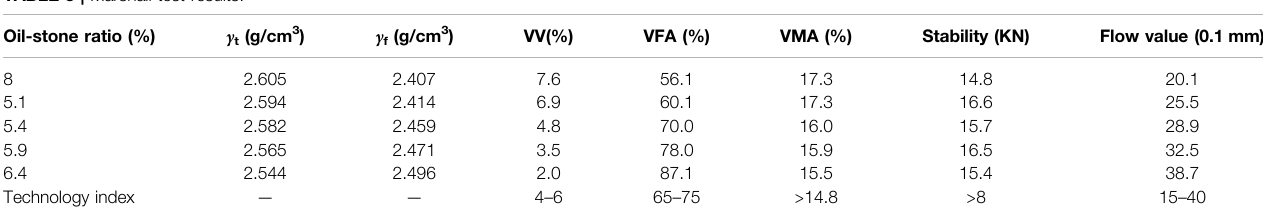
TABLE 3 | Marshall test results.